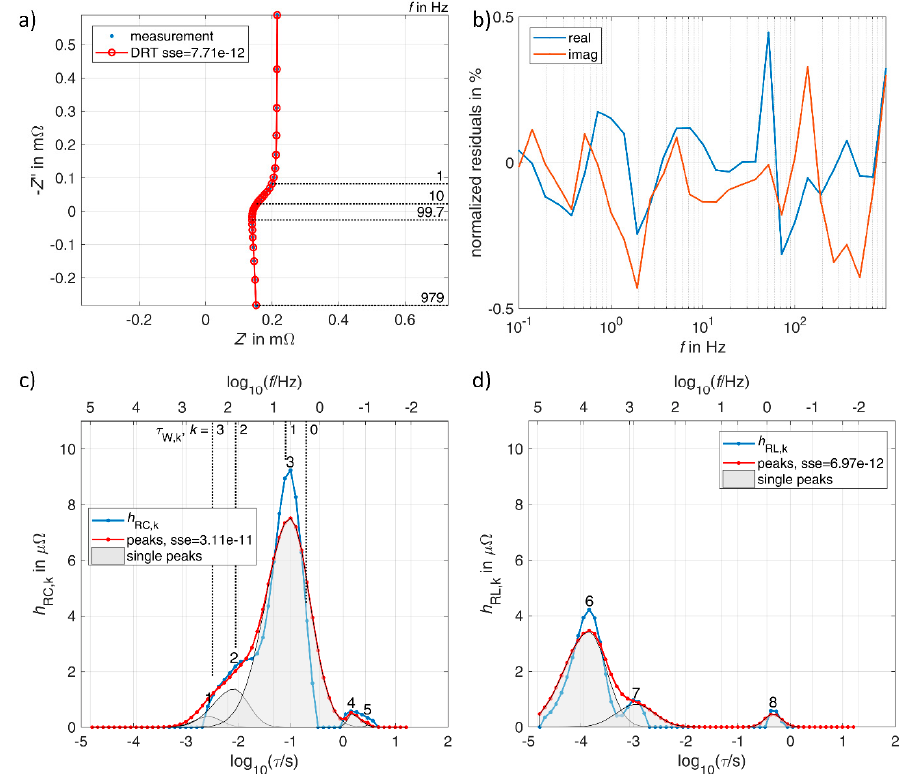
Figure 6. Generalized DRT analysis of a double layer capacitor (Maxwell, 3400 F, 2.85 V) with the sum of squared errors ( 𝑠𝑠𝑒 ) of each plot. ( a ) Measured and calculated impedance spectrum; ( b ) Normalized residuals of real and imaginary part of the impedance spectra of subplot ( a ); ( c ) Identified resistive-capacitive distribution of relaxation times function; ( d ) Identified resistive-inductive distribution of relaxation times function.